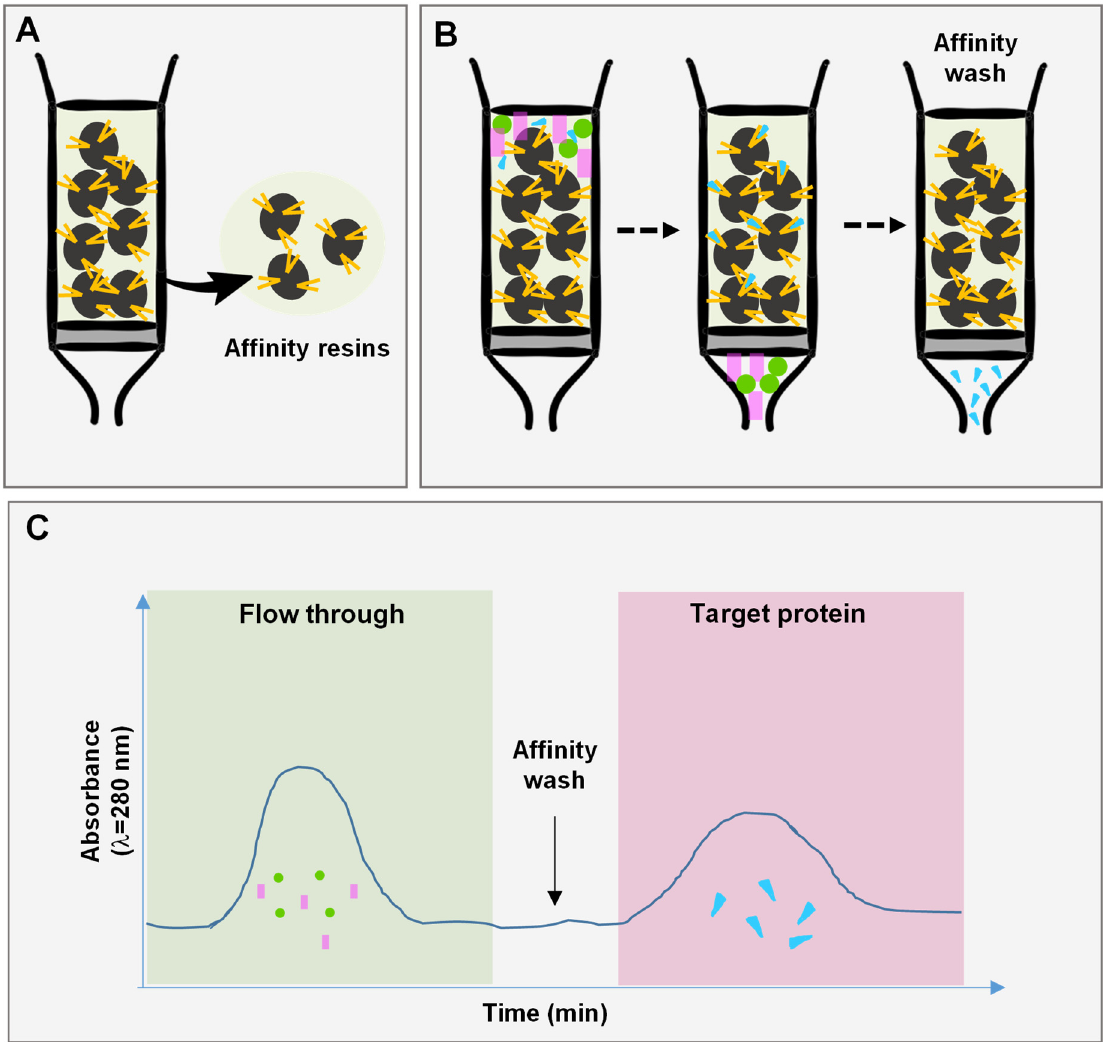
Figure 2. Schematic representation of affinity chromatography. ( A ) The affinity resins (i.e., agarose) that binds the molecule of interest and ( B ) the separation process, which includes an equilibration step (using Tris-HCl or sodium acetate) followed by the elution (using Tris-HCL/Glycine-HCl, PBS). ( C ) A typical chromatogram of affinity chromatography with the first flow through containing only molecules with no affinity to the matrix, which is followed by affinity wash to disrupt the interaction between the matrix and the target protein and elute the latter.